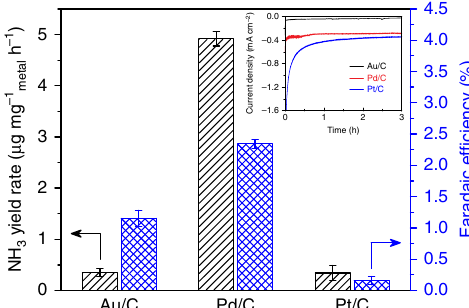
Fig. 3 Comparison of the Pd/C catalyst with Au/C and Pt/C catalysts for N 2 RR. NH 3 yield rates and Faradaic ef fi ciencies of the Au/C, Pd/C, and Pt/ C catalysts on the carbon-paper support measured in N 2 -saturated 0.1 M PBS electrolyte at − 0.05 V vs. RHE. The error bars correspond to the standard deviations of measurements over three separately prepared samples under the same conditions. Inset: chronoamperometric curves obtained for each catalyst